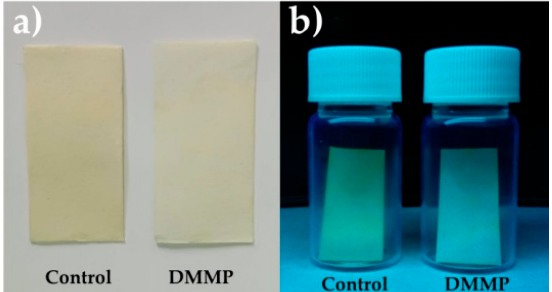
Figure 10. Test strip on filter paper (2.5 × 3 cm) adsorbed with the Zn–Oligo–C solution (1 × 10 − 3 M in DMSO), before (Control) and after (DMMP) the exposure to DMMP vapors (a 20 mL vial